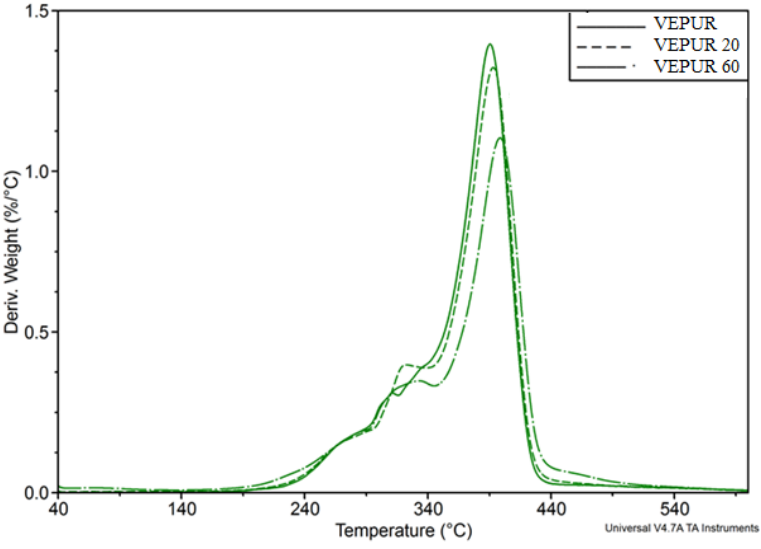
Figure 12. Comparison of DTG curves of VEPUR, VEPUR 20, and VEPUR 60.